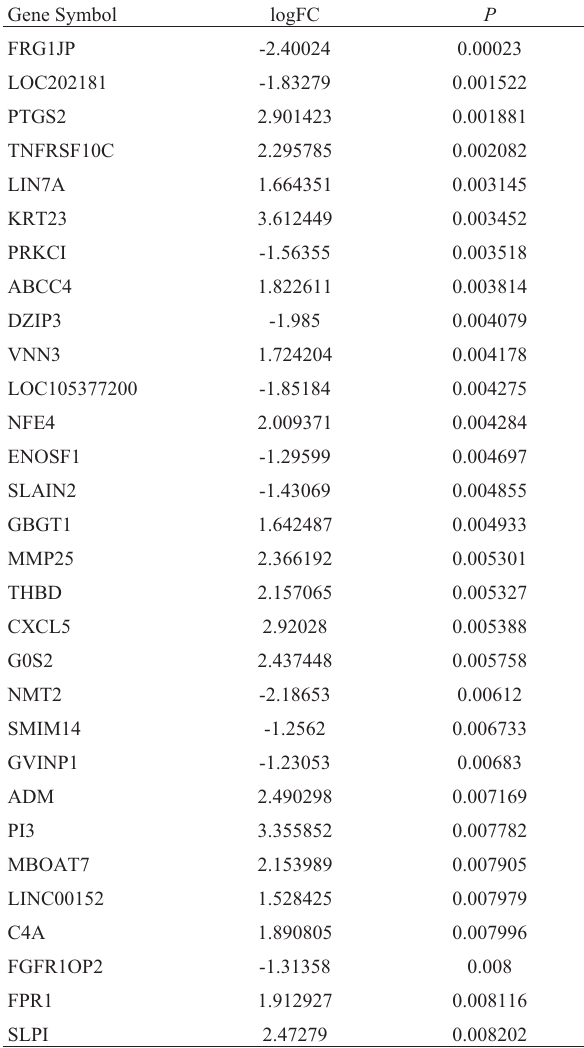
Table 4 - The top differentially expressed